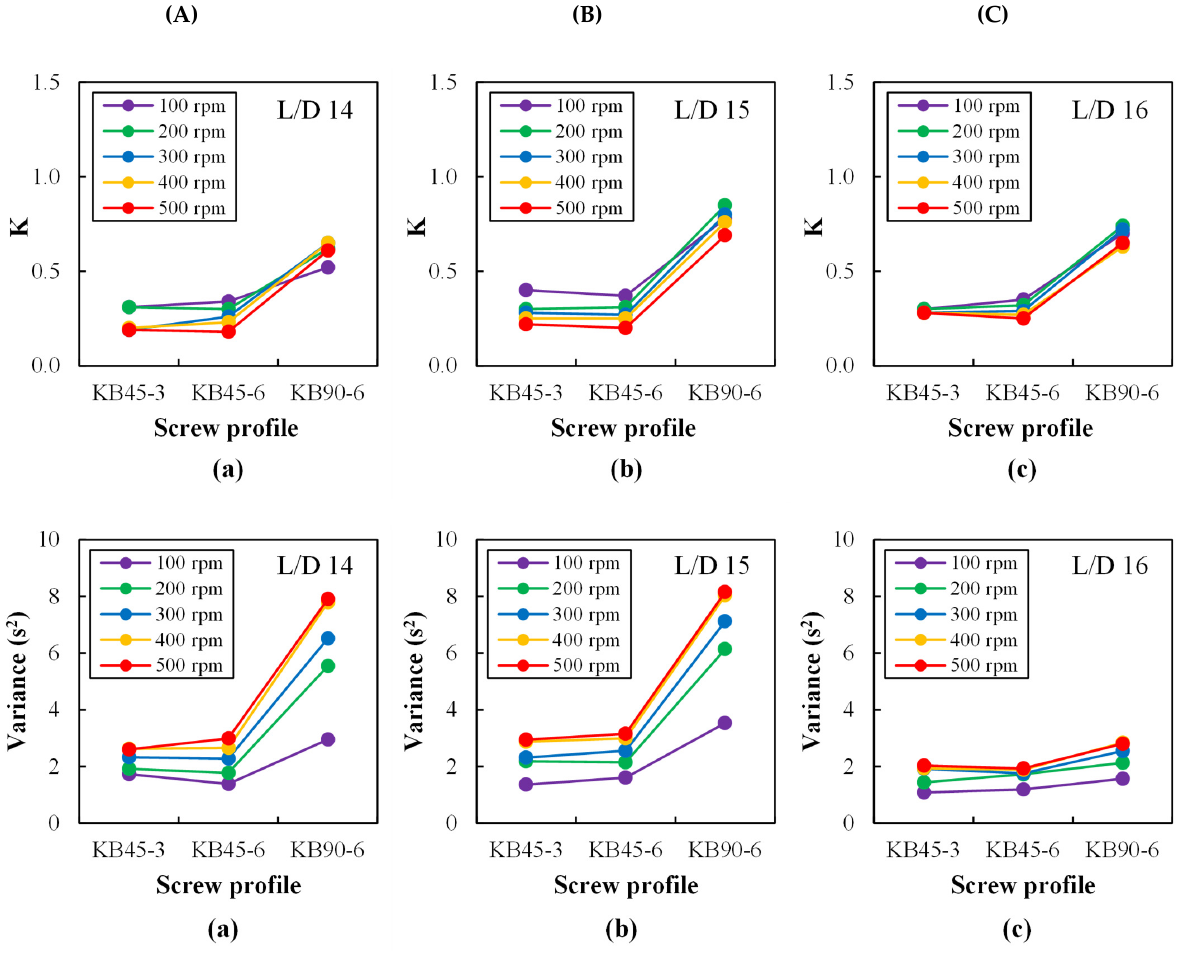
Figure 9. Area constant (K) and variance ( σ 2 ) based on RTD curves measured with the barrel set to 230 °C along the mixing zone at ports: ( a ) L/D = 14, ( b ) L/D = 15, and ( c ) L/D = 16 for different kneading blocks ( A : KB45-3, B : KB45-6, and C : KB90-6) and various screw speeds (100 to 500 rpm).